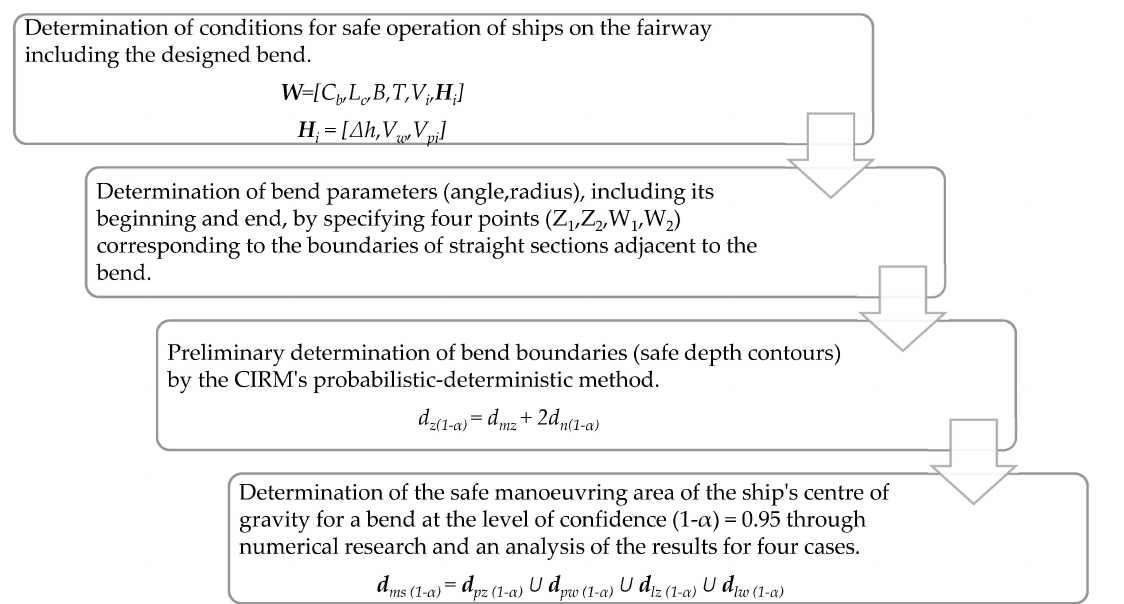
Figure 4. Algorithm of the dimensioning of the safe manoeuvring area of a bend by the kinematic method of numerical simulation.